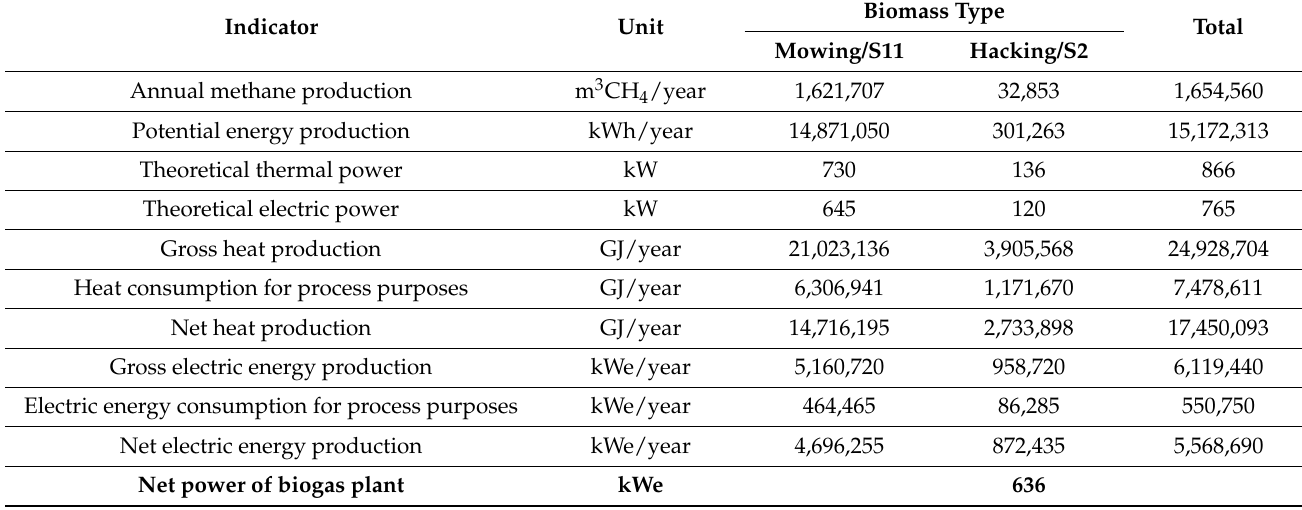
Table 7. Energy balance of methane fermentation of hydrophytes harvested in Warmia–Mazury